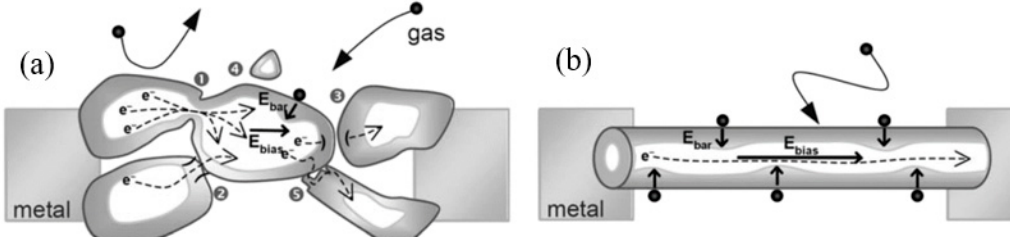
Figure 5. Diagrams illustrating the difference in gas sensing effects in ( a ) the polycrystalline material and ( b ) individual nanowires: One can see that any intergrain necks or boundaries are absent in 1D-based sensors. Moreover, E bar and E bias fields are always orthogonal and independent. Reproduced with permission from Hernandez-Ramirez et al. [149]. Copyright 2009: Royal Society of Chemistry.